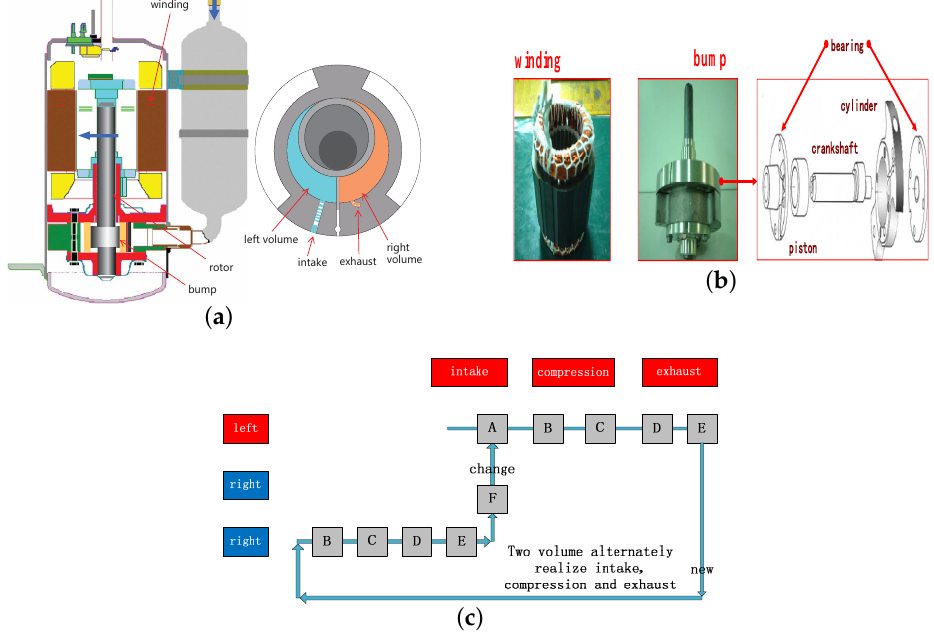
Figure 1. Structural diagram of the inverter compressor and operating procedure: ( a ) inverter compressor structure diagram; ( b ) winding and bump; ( c ) operation cycle.